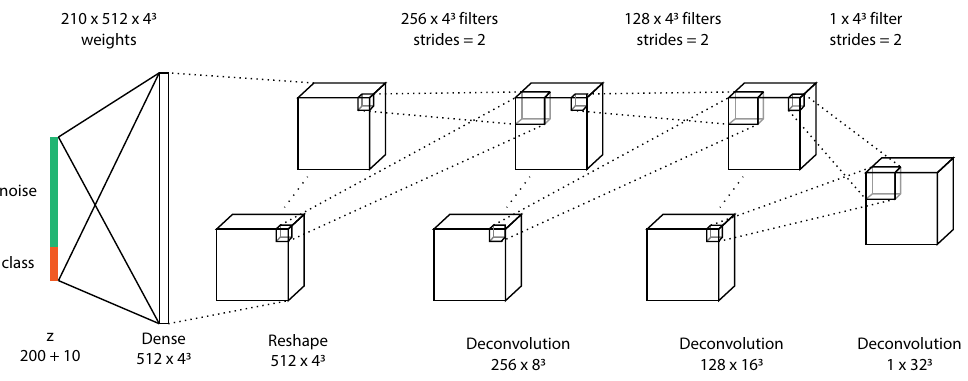
Figure 3. Architecture of the generator network. Input vector z consisting of a gaussian noise vector and a condition (class) vector is expanded in a fully connected stage and then is deconvoluted three times with batch normalization and ReLU activation function in between.